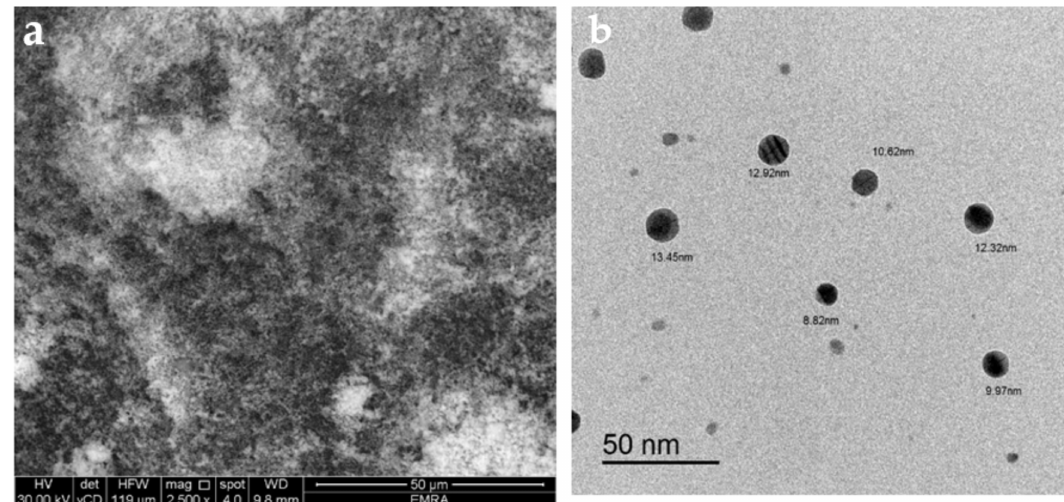
Figure 5. ( a ) Scanning electron microscopy (SEM) and ( b ) transmission electron microscopy (TEM) micrographs of the synthesized